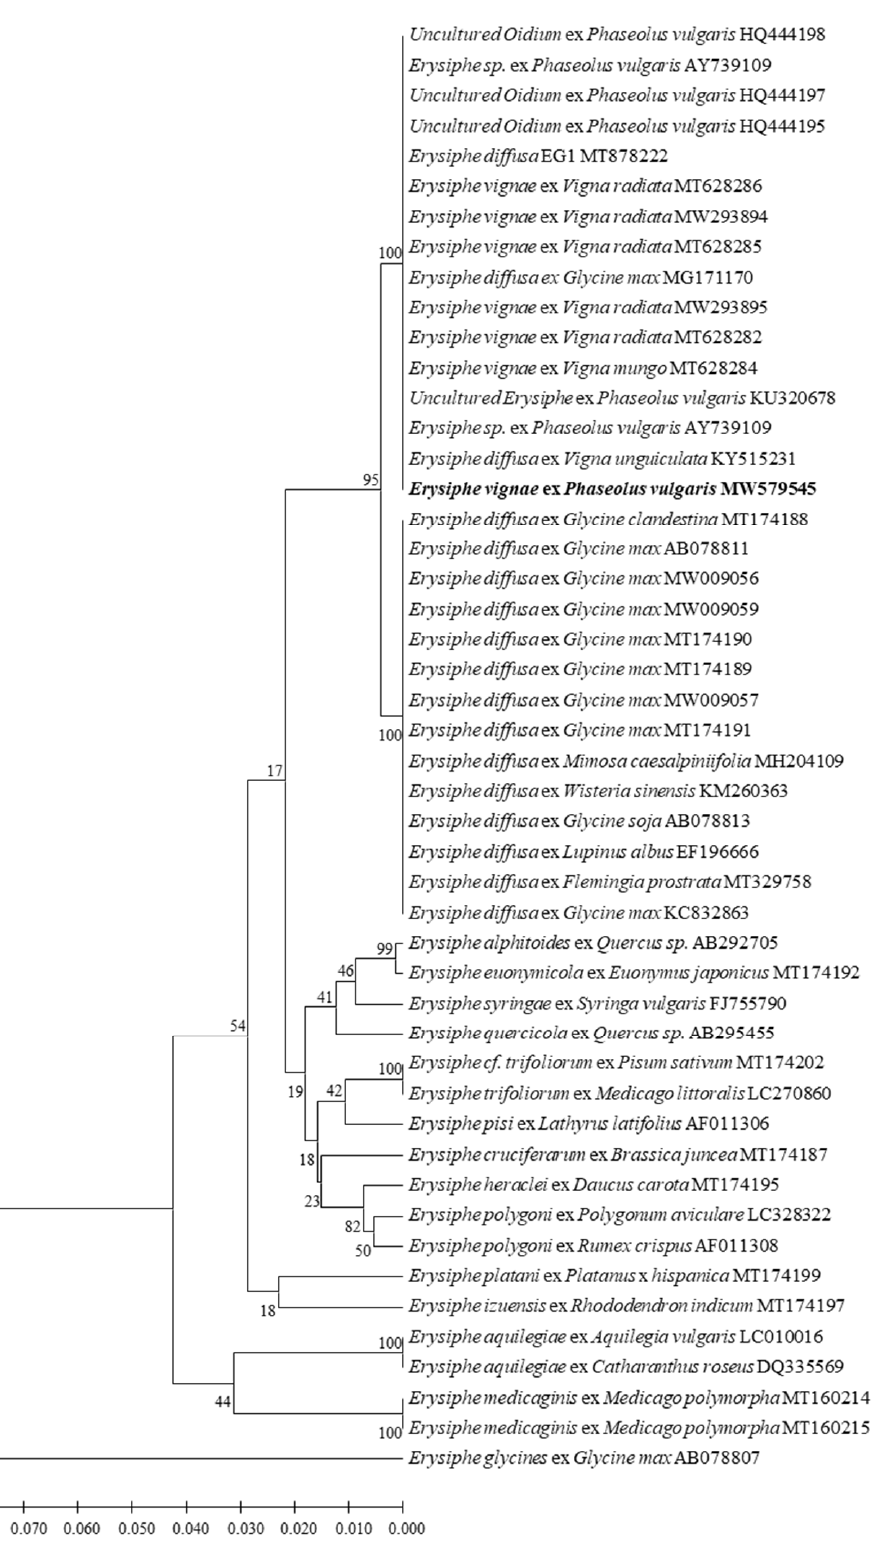
Figure 3. Phylogenetic tree inferred from Neighbor-joining analysis of the ITS sequences in this study and GenBank (Table 1). The tree is rooted to the ITS sequence of Erysiphe glycines (AB07807). The 5 (cid:48) -end of the nrDNA large subunit (LSU) gene sequences alignment analysis showed that the sequence of CBPM1 was 100% identical to the two E. vignae